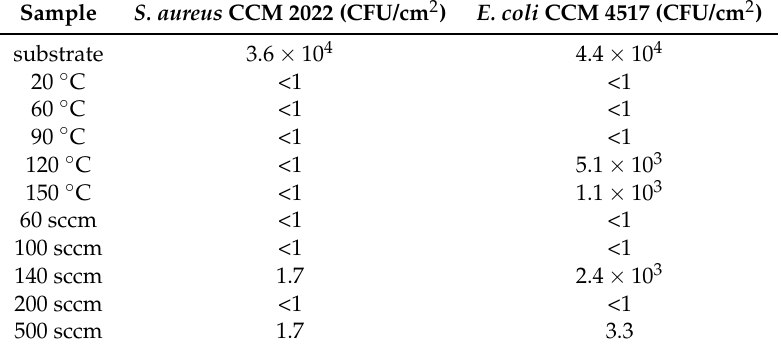
Table 2. Antibacterial activity results of studied POx films. Substrate marks bare glass substrate. The samples marked with temperature were deposited at this substrate temperature and the flow rate of 100 sccm. The samples marked with flow rate were deposited at this flow rate and the substrate temperature of 120 ◦